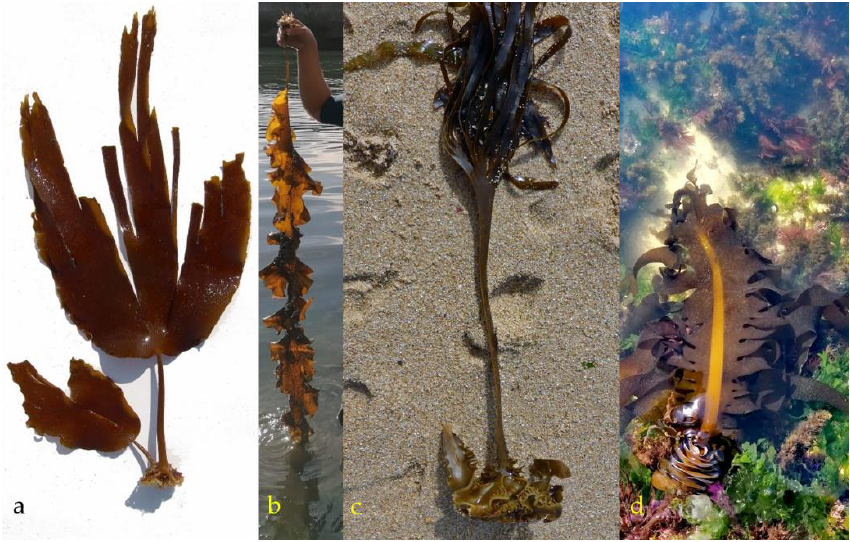
Figure 1. Photographic record of ( a ) Laminaria ochroleuca, ( b ) Saccharina latissima, ( c ) Saccorhiza polyschides, and ( d ) Undaria pinnatifida.